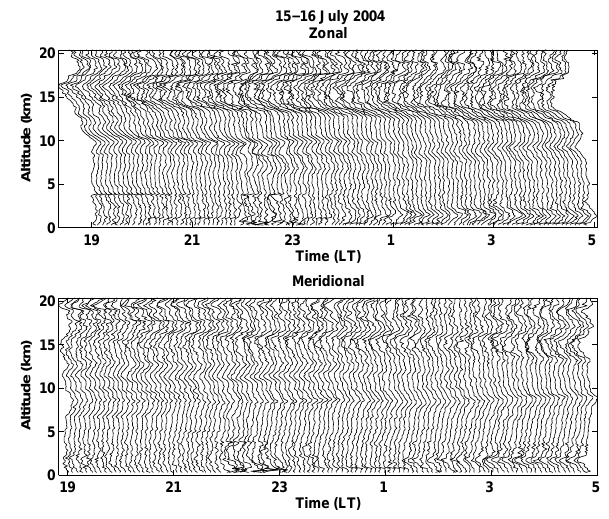
Fig. 1. One hour averaged sample profiles of zonal (a) , merid- ional (b) and vertical (c) winds measured by LAWP and MST radar between 13:00–14:00LT. Comparisons of zonal (solid) and merid- ional (dashed) winds measured by LAWP (red) and MST radar (black) for two overlapping heights (d) . Temperature profile over Chennai (e) and vertical beam echo power measured by MST radar (averaged between 13:00–14:00LT) (f) .